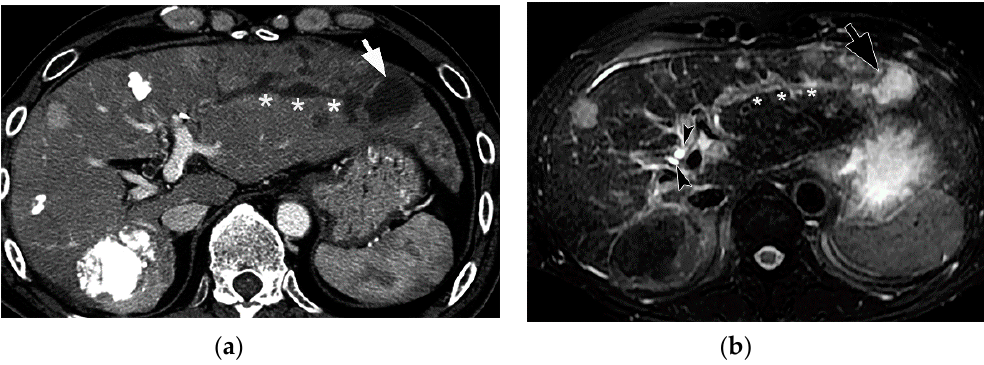
Figure 13. Comparison between CT and T2-weighted MRI findings of BDN. ( a ) On contrast-enhanced CT, a hypodense irregular tubular structure (*) is observed in the left lateral segment of the liver. Although this tube-like structure looks like irregularly dilated intrahepatic bile ducts, it is BDN. Biloma formation (arrow) is observed at the peripheral portion of the lateral segment which is connected to BDN. On the hepatic hilum, slightly dilated right and left hepatic ducts are observed (arrowheads). ( b ) On T2-weighted MRI, BDN (*) and biloma (arrow) on the left lateral lobe of the liver do not show marked hyperintensity like the hepatic ducts (arrowheads), but instead show slight hyperintensity. This finding suggests that BDN and biloma are not pure fluid-filled spaces, but “necrotic tissue”. (Figure 13a is same figure as Figure 9. It is presented for comparison with Figure 13b).